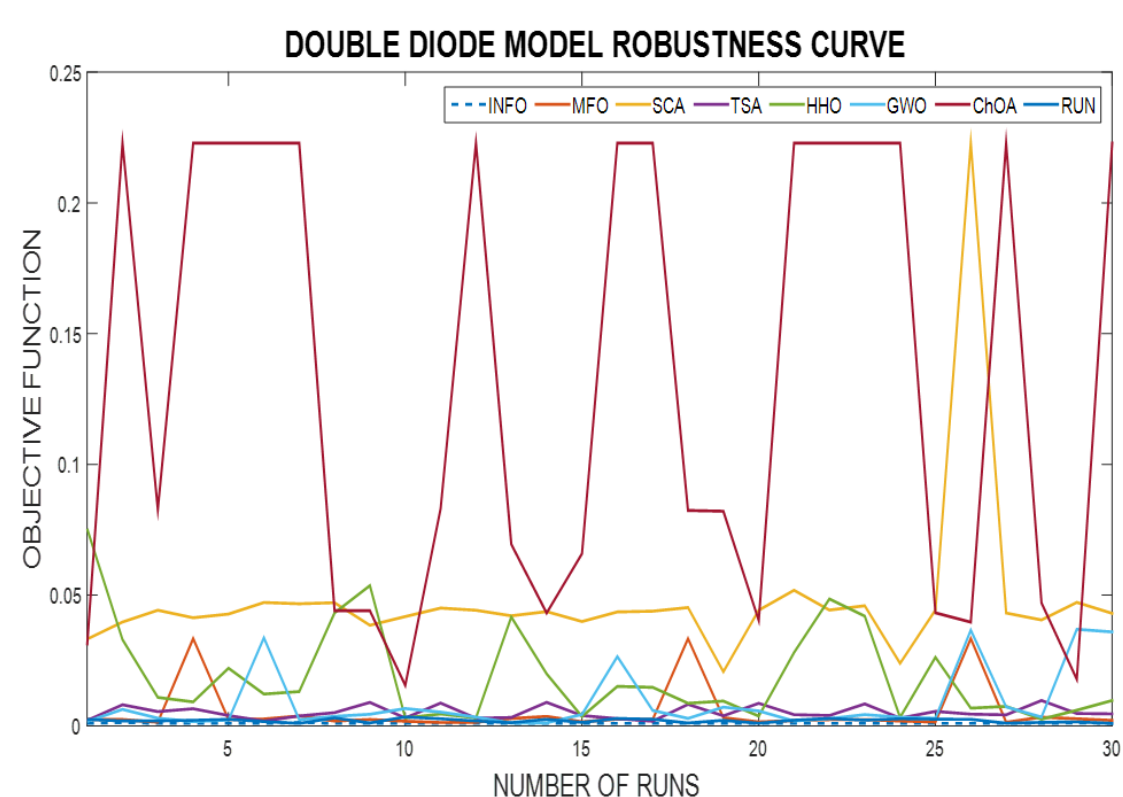
Figure 14. Robustness curve of the DDMSC.